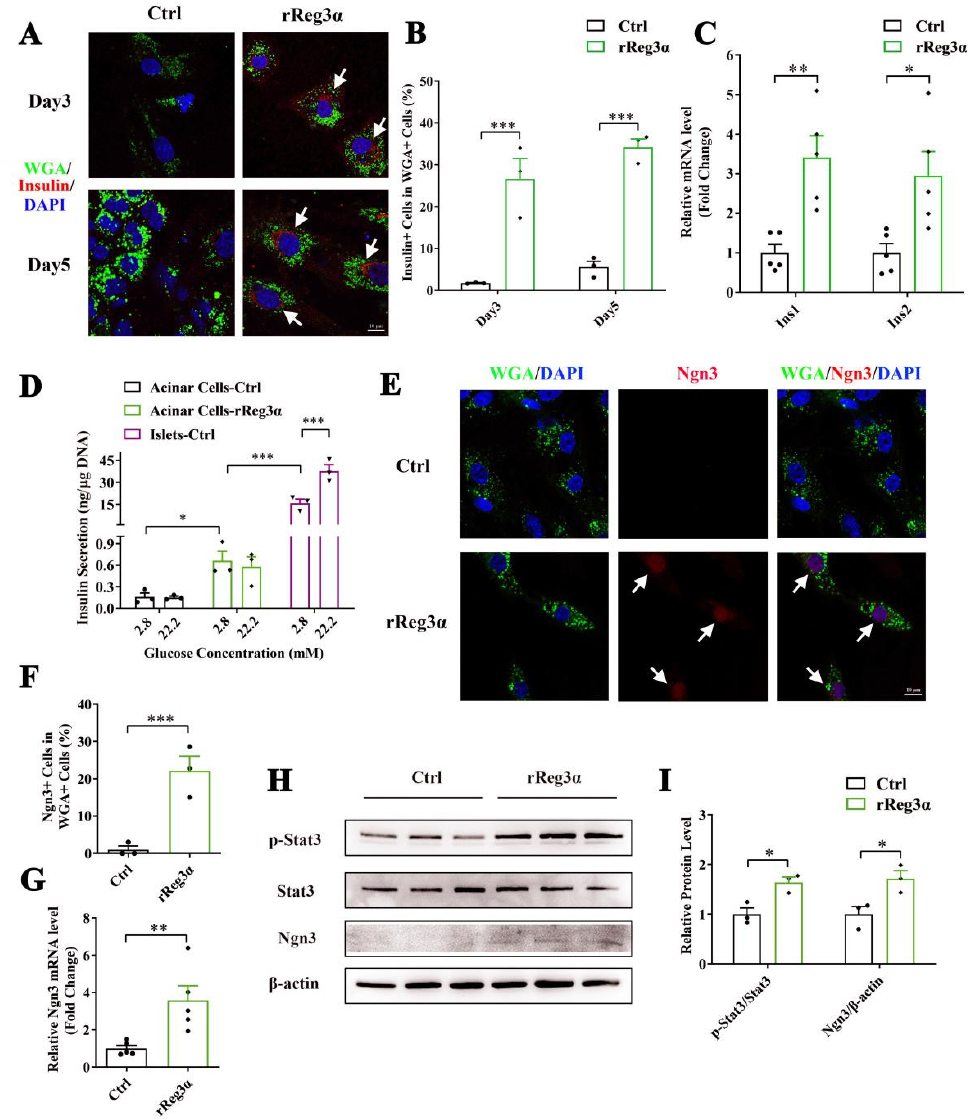
Figure 5. rReg3 α promotes β -cell neogenesis in isolated acinar cells. ( A ) Confocal micrographs of immunofluorescent staining to insulin and WGA (630× magnification) in the isolated acinar cells treated with rReg3 α at d 3 and 5. Cell nuclei were labeled with DAPI. A representative image is illustrated from each group. White arrows indicate the insulin + /WGA + cells. ( B ) Statistical analysis of the insulin + /WGA + cells in the total WGA + cells in panel A. *** p < 0.001 using Student’s t -test, N = 3. ( C ) qRT-PCR analysis of Ins1 and Ins2 expression at d 3. * p < 0.05 and ** p < 0.01 using Student’s t -test, N = 5. ( D ) GSIS assay in the isolated acinar cells and primary islets at d 3. * p < 0.05 and *** p < 0.001 using one-way ANOVA, N = 3. ( E ) Confocal micrographs of immunofluorescent staining to Ngn3 and WGA (630× magnification) at d 3. Cell nuclei were labeled with DAPI. A representative image is illustrated from each group. White arrows indicate the Ngn3 + /WGA + cells. ( F ) Statistical analysis of the Ngn3 + /WGA + cells in the total WGA + cells in panel E. *** p < 0.001 using Student’s t - test, N = 3. ( G ) qRT-PCR analysis of Ngn3 expression at d 3. ** p < 0.01 using Student’s t -test, N = 5. ( H ) Western blotting of Stat3 phosphorylation and Ngn3 level in the isolated acinar cells at d 3. ( I ) Densitometric quantification of the protein levels in panel H. The relative phosphorylated Stat3 content was corrected by the total Stat3 and the relative Ngn3 content was corrected by β -actin. * p < 0.05 using Student’s t -test, N = 3.